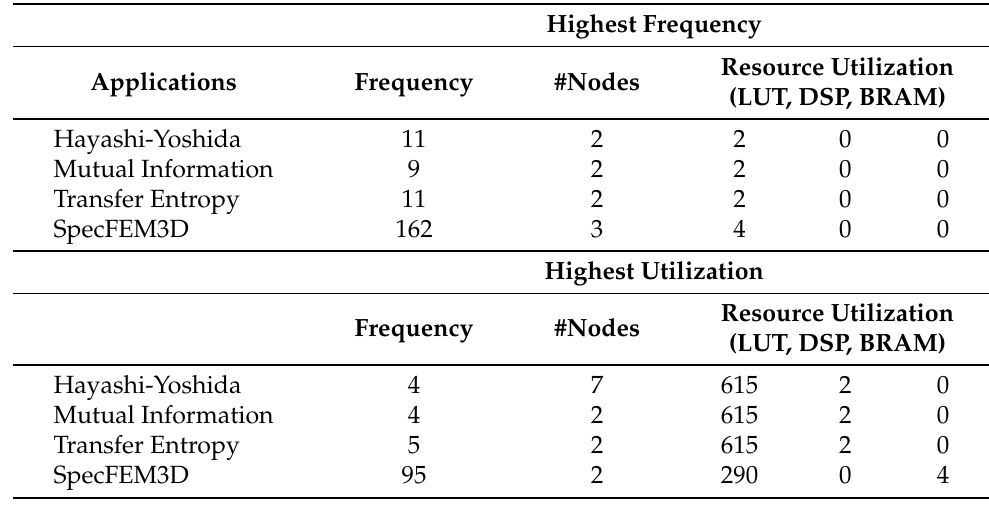
Table 2. Frequent sub-graph characteristics for each